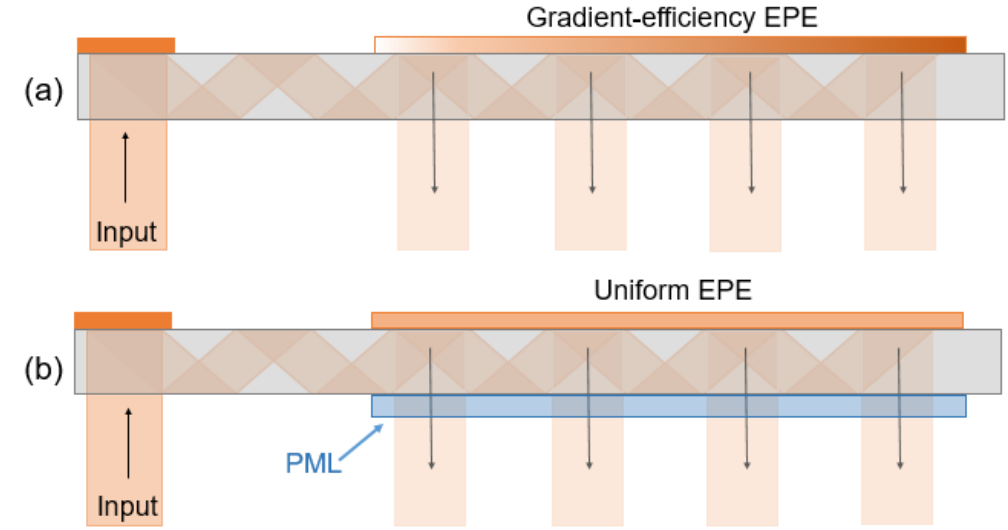
Figure 13. Schematic illustration of waveguide-based optical systems. ( a ) Using gradient-efficiency output coupler. ( b ) Using uniform-efficiency output coupler with a PML.